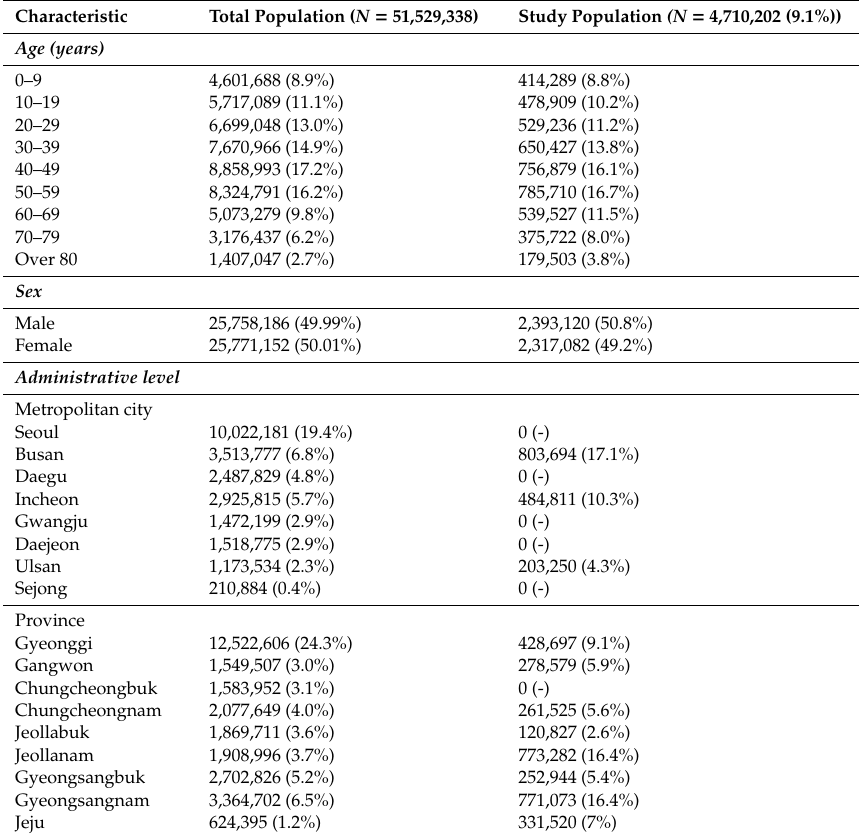
Table 1. Characteristics of study population.